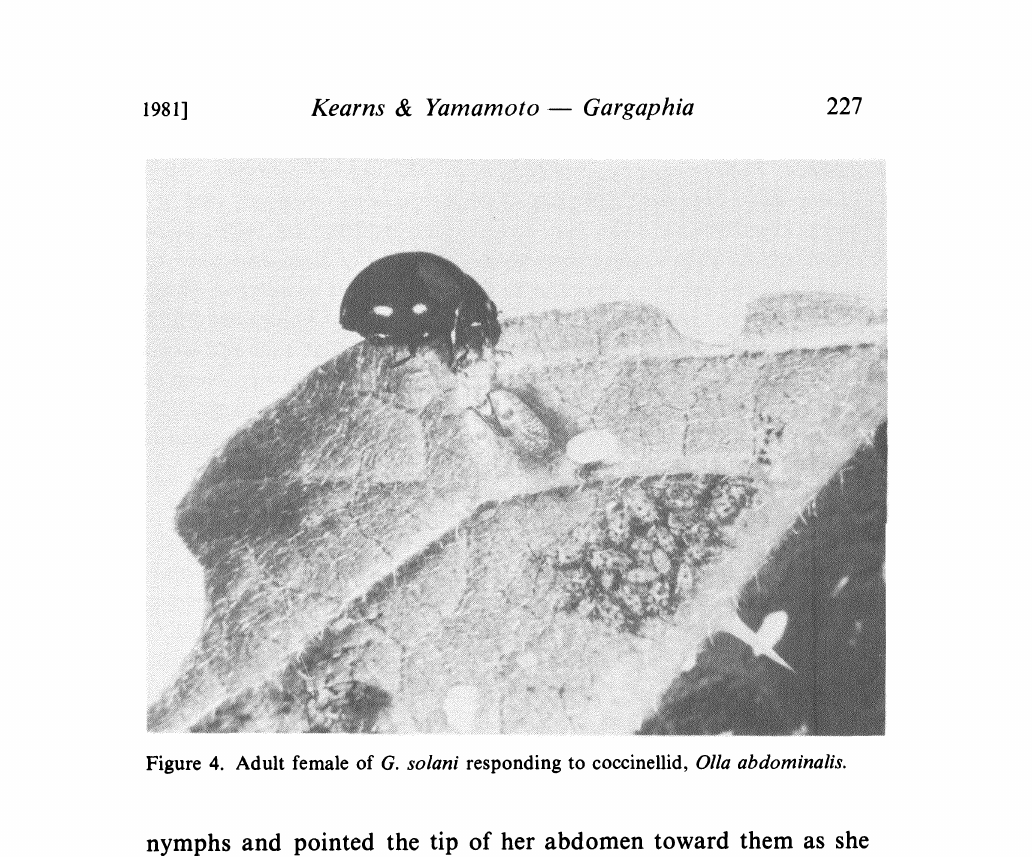
Figure 4. Adult female of G. solani responding to coccinellid, Olla